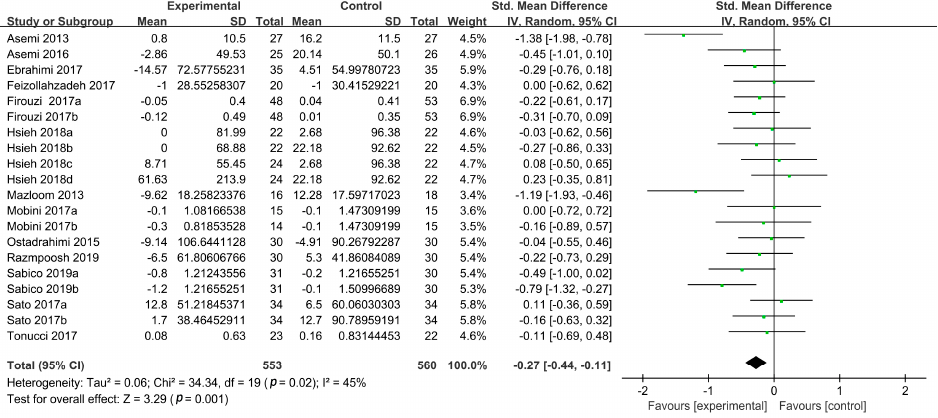
Figure 4. Forest plot of the effects of probiotics on TG concentrations.